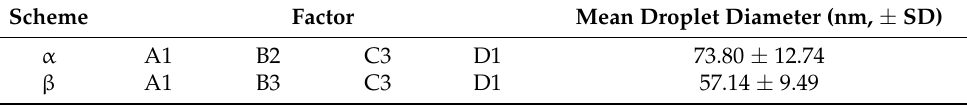
Table 4. Experimental results on mean droplet diameters of Scheme α and Scheme β . Scheme